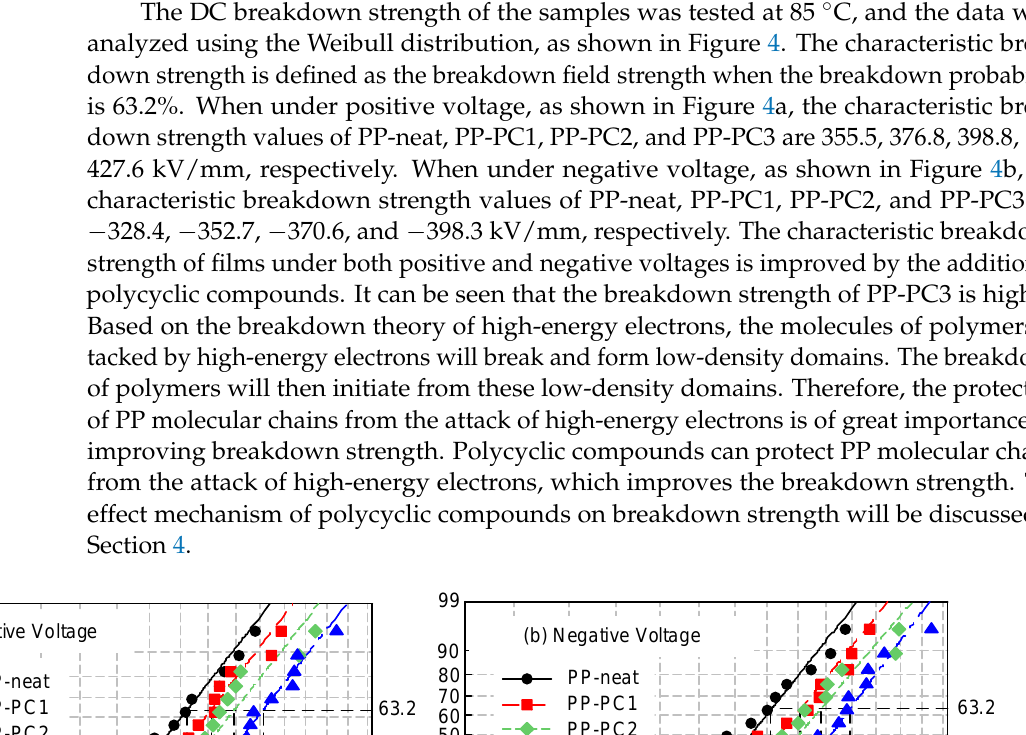
Figure 3. Relationship between the DC conductivity, electric field, and temperature ( a ) under 25 kV/mm ( b ) at 85 °C.